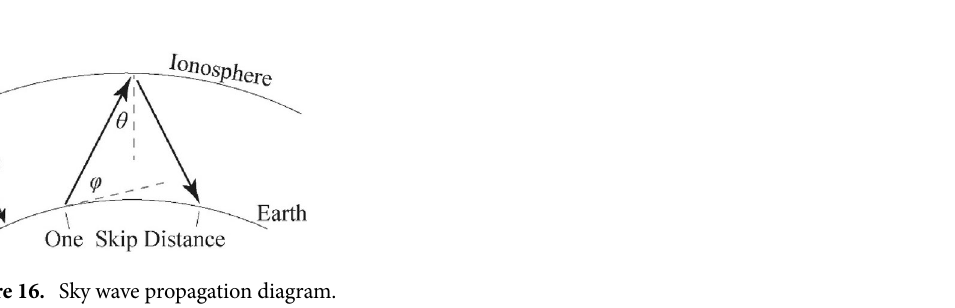
Figure 16. Sky wave propagation